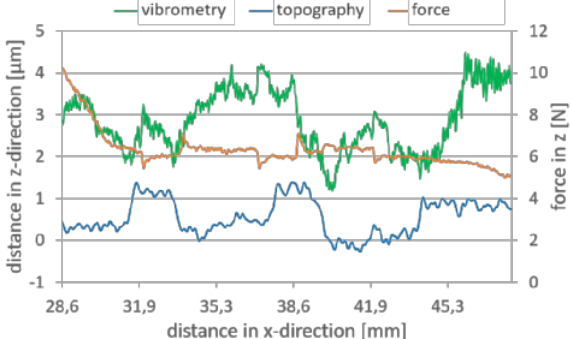
Fig. 3. Synchronized vibrometry, force and topography data for a sample surface (temperature compensation active) This shows, that it is possible to find the